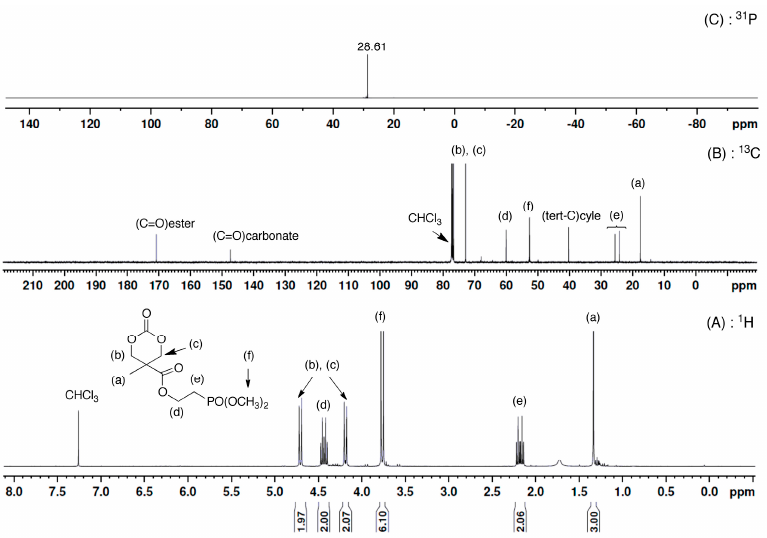
Figure 1. Overlaid 1 H ( A ), 13 C ( B ), and 31 P ( C ) NMR spectra of 4 in CDCl 3